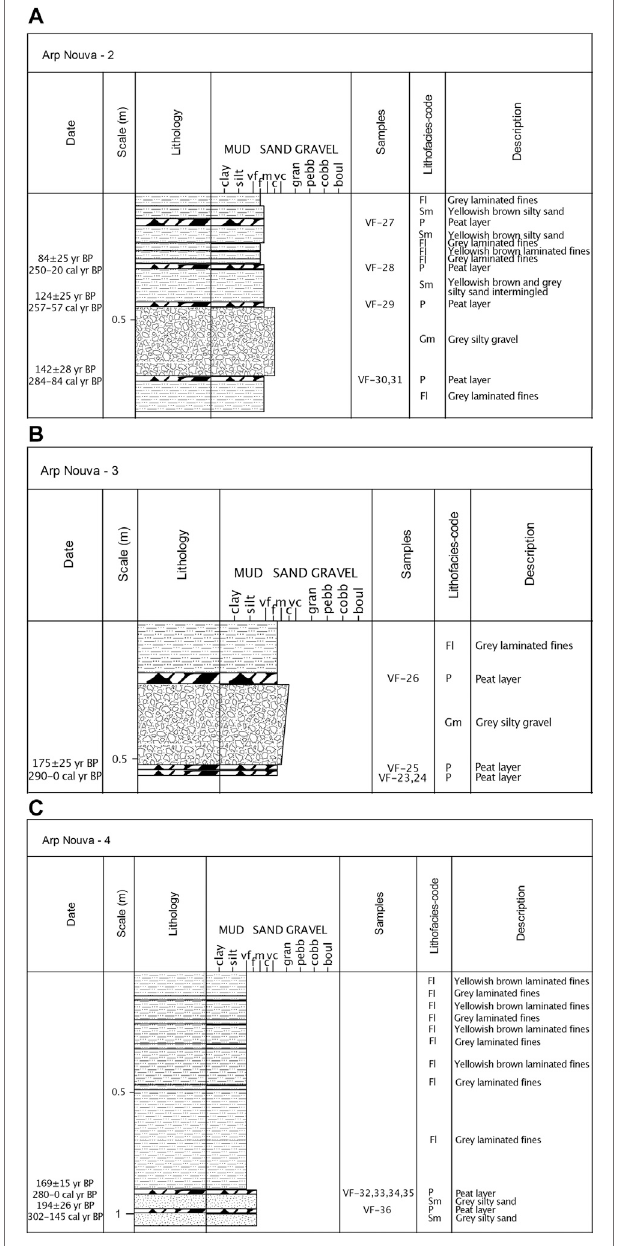
FIGURE4| Samplesandthedescriptionofsoilpro fi lesfromthepits: (A) Arp Nouva-2, (B) Arp Nouva-3 and (C) Arp Nouva-4.